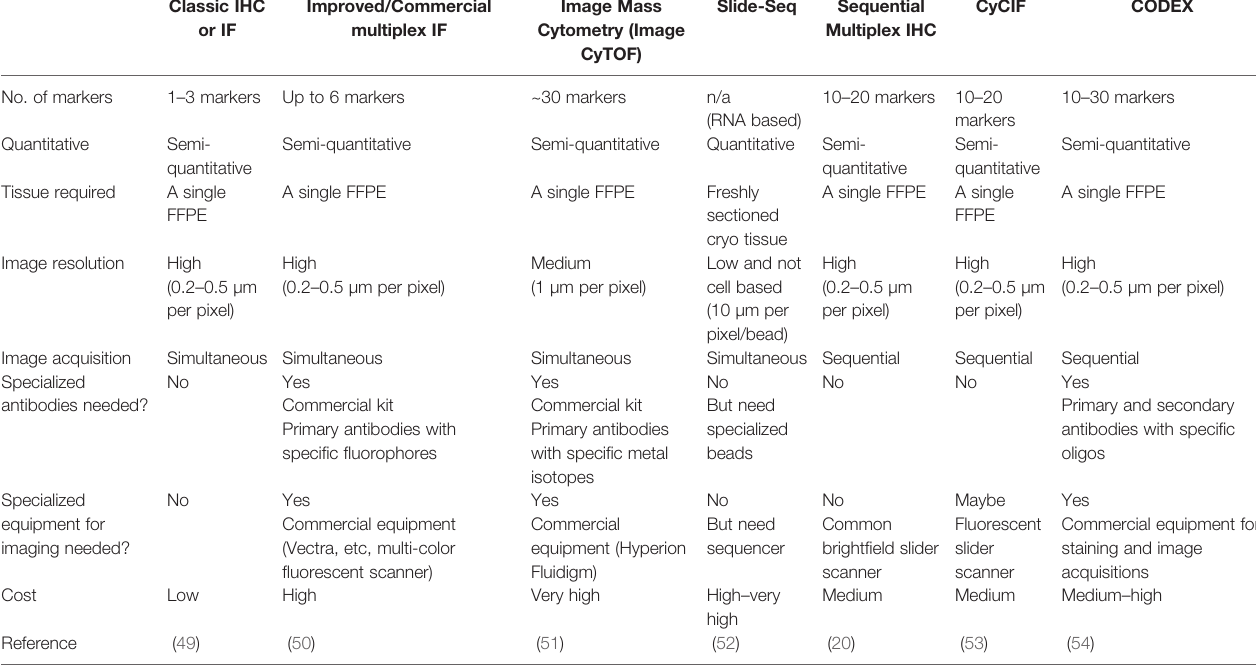
TABLE 4 | Summary of multiplex imaging